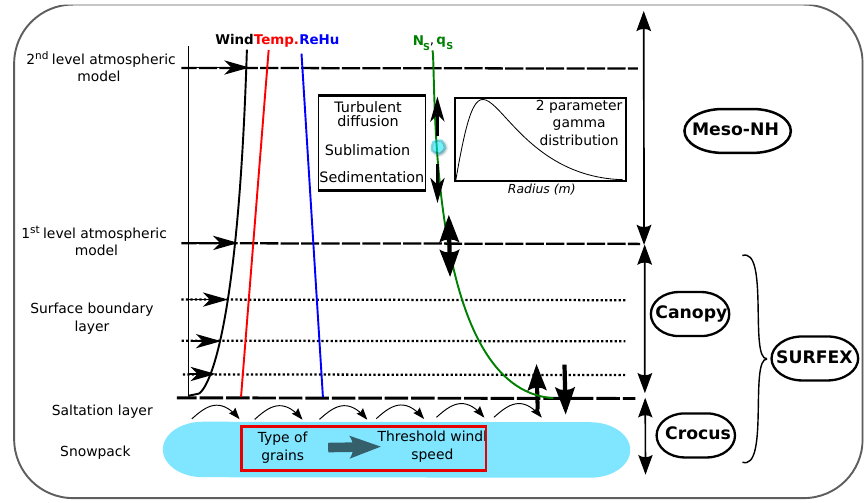
Fig. 1. Components of the blowing snow scheme in Meso-NH/Crocus. N s denotes the number concentration per unit of mass of blown snow particles and q s the blowing snow mixing